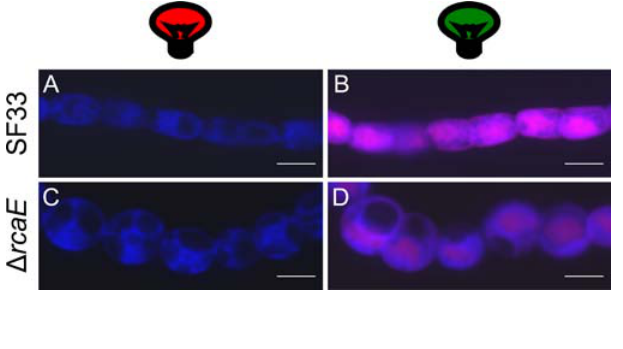
Figure 9. Phycobiliprotein autofluorescence of Fremyella diplosiphon strains grown in broad-band red and green light. Wild-type pigmentation SF33 (A, B) and Δ rcaE mutant